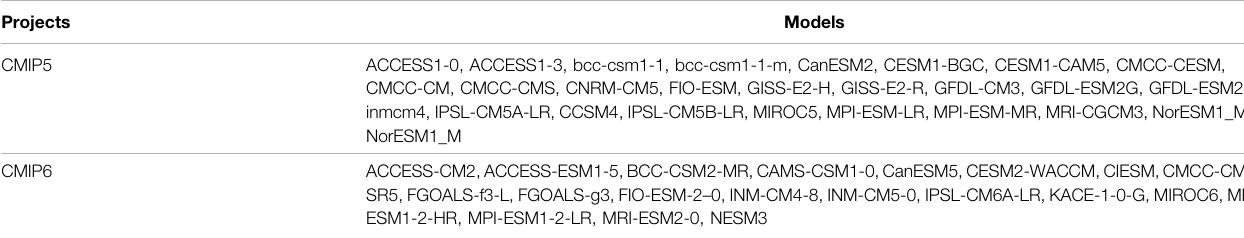
TABLE 1 | The models applied in this